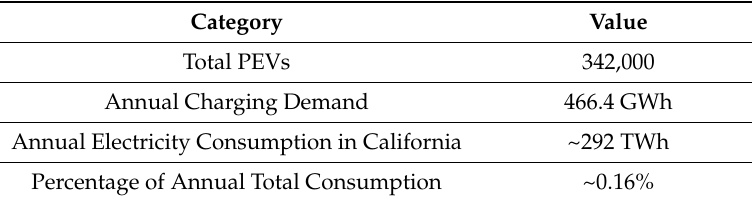
Table 5. Total Annual Charging Demand in 2017.